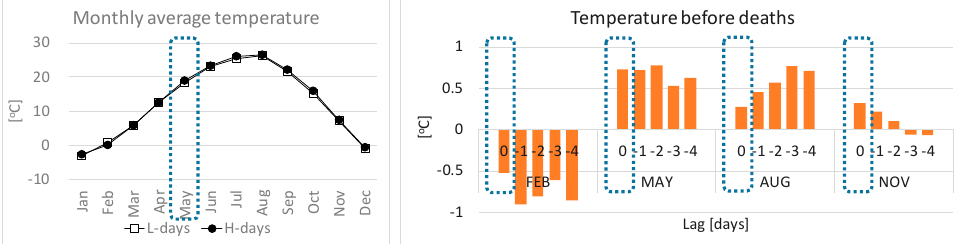
Figure 7. Temperatures on days with a higher or lower probability of deaths from respiratory disease, and temperatures from zero to 5 days before deaths in May between 2008 and 2017.